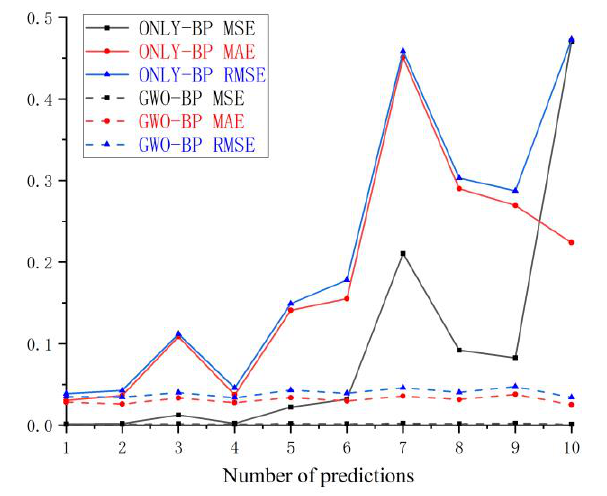
Figure 10. Error analysis of random 10-time neural network prediction.